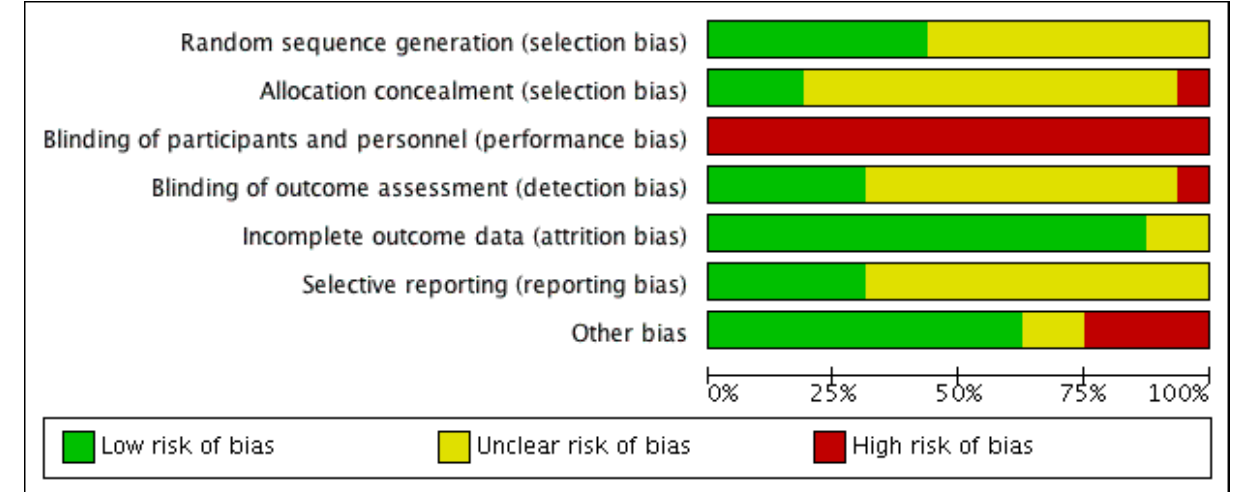
Figure 4. Authors’judgments about each risk of bias item presented as percentages across all included